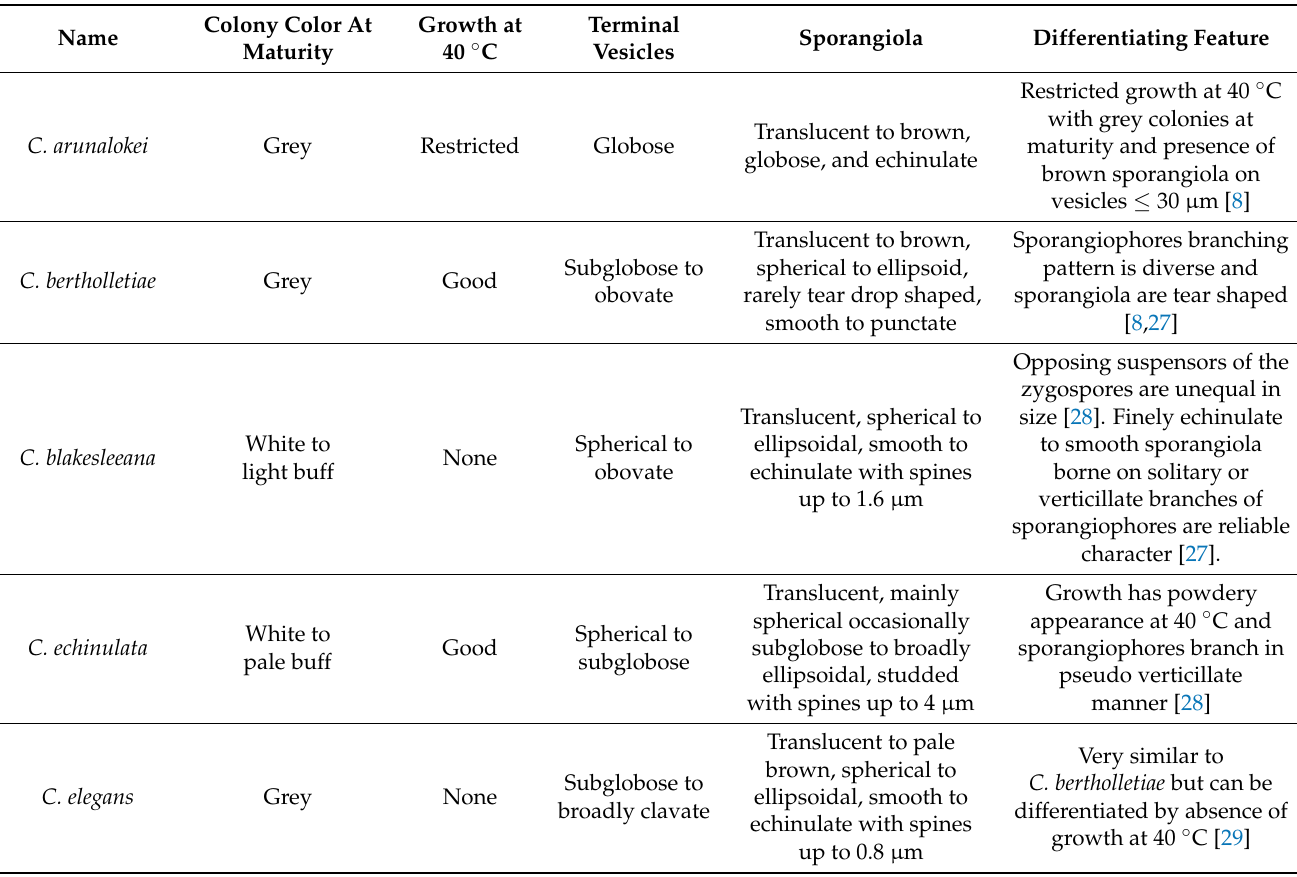
Table 2. Showing phenotypic characters to differentiate clinically relevant Cunninghamella